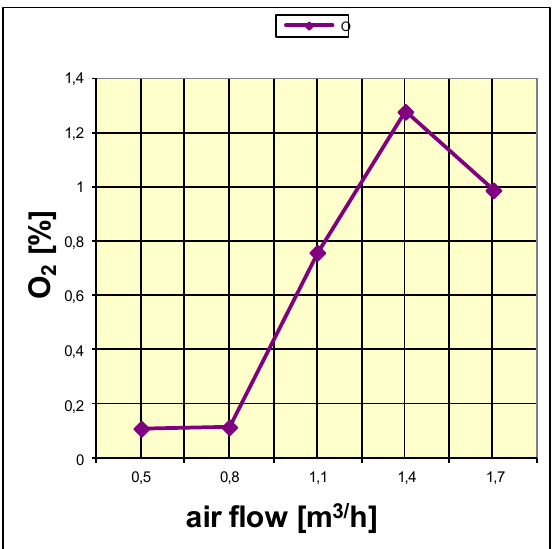
Fig. 4 . Share of oxygen in synthesis gas.